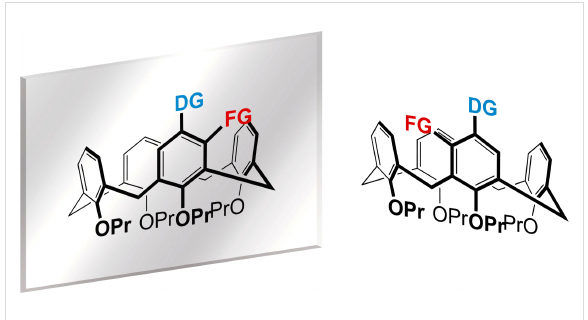
Figure 1: Inherent chirality generated by meta -substitution – the two structures are non-superposable mirror images, thus enantiomers. DG = directing group; FG = any functional group.